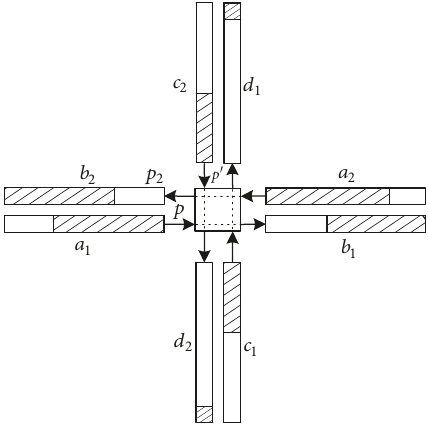
Figure 3: The case with similar queue length for downstream and upstream